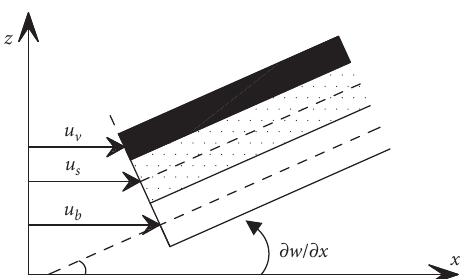
Figure 2: Local deformation relation of the stand-off free layer damping cantilever